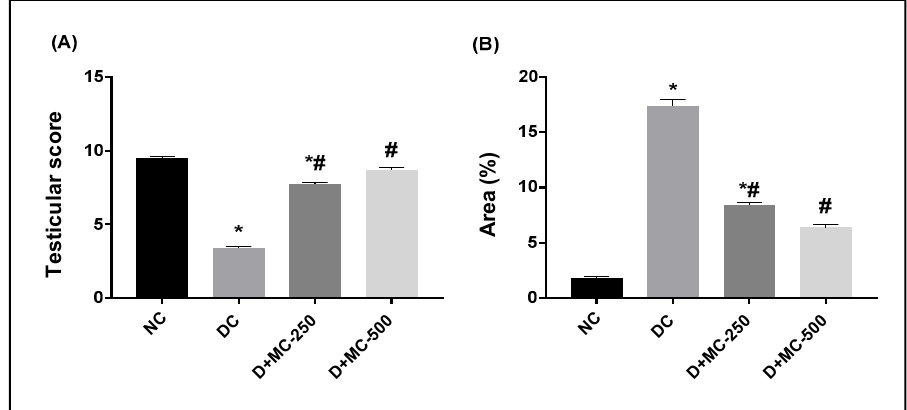
Figure 4. Bar charts of testicular lesion score and immunohistochemical analysis of anti-caspase-3 in experimental groups: ( A ) testicular lesion score and ( B ) caspase-3 immunopositive reaction expressed as area %.* Significantly different from NC group; # significantly different from DC group.